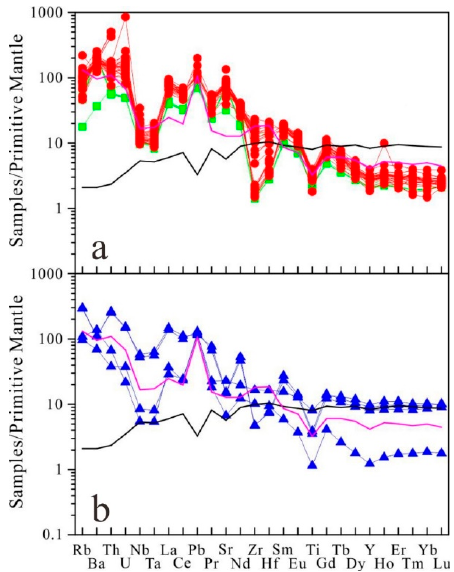
Figure 7. Primitive mantle normalized spider diagrams of diorites ( a ) and granites ( b ) from the Anqing orefield. Primitive mantle data are taken from [57]. Symbols are as in Figure 4. In addition, the data of two granites from the Dalongshan [49] have been incorporated into Figure 5b.